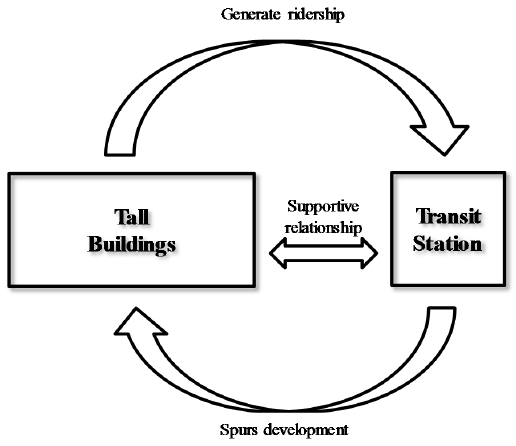
Figure 7. Tall buildings and rail transit feature mutually supportive relationship. Buildings 2018 , 8 , x FOR PEER REVIEW